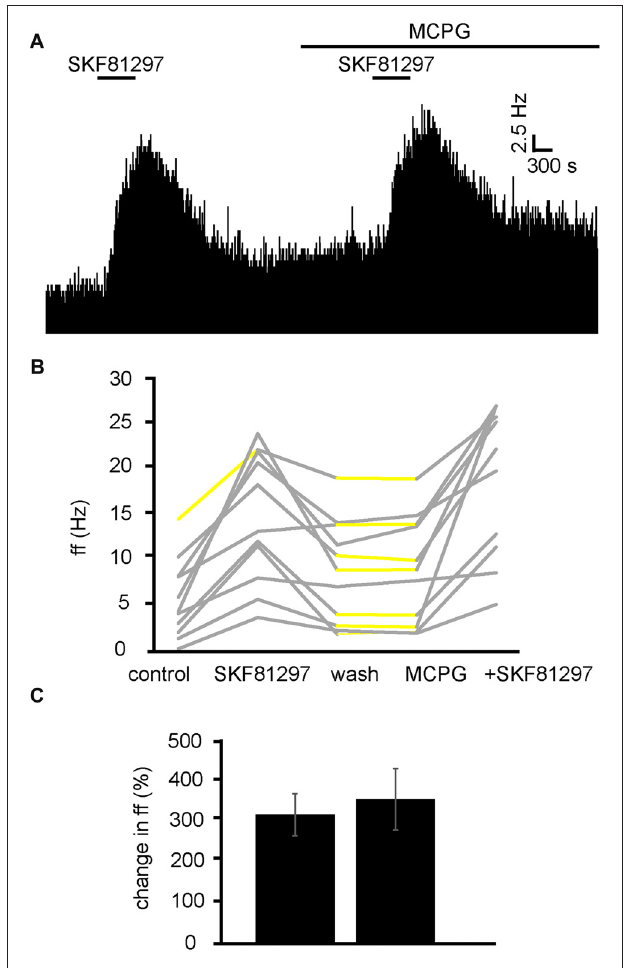
FIGURE 10 | D1-like receptor agonists continue to excite VP neurons in the presence of MCPG. (A) Excitatory responses to SKF81297 application alone and in the presence of MCPG. (B) Changes in firing frequency for 11 VP neurons to application of SKF81297 and SKF81297 in the presence of MCPG, similar to that illustrated in panel (A) . Firing frequency was measured; before the application of SKF81297, during the application of SKF81297, after wash out of SKF81297, during application of MCPG and finally during the application of SKF81297 in the presence of MCPG. Responses characterized by significant ( P < 0.05) changes in firing frequency are in gray, the other ones in yellow. (C) Firing frequency in response to SKF81297 compared to SKF81297 in the presence of